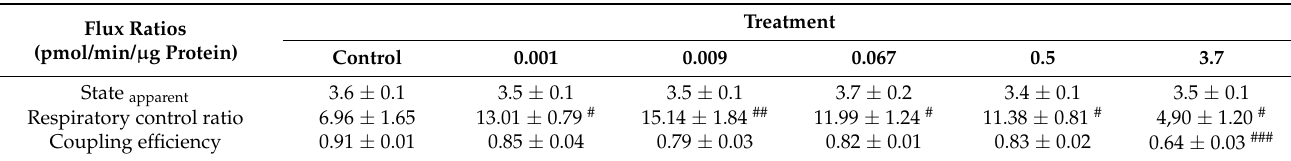
Table 1. Respiratory flux ratios of DMSO treated H9c2 cells.